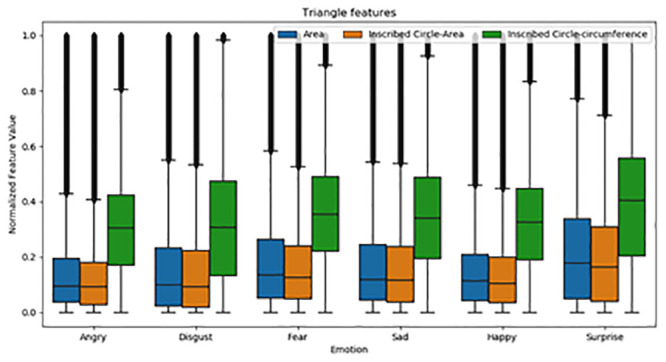
Distribution of the mean value of triangular features in emotion classification.